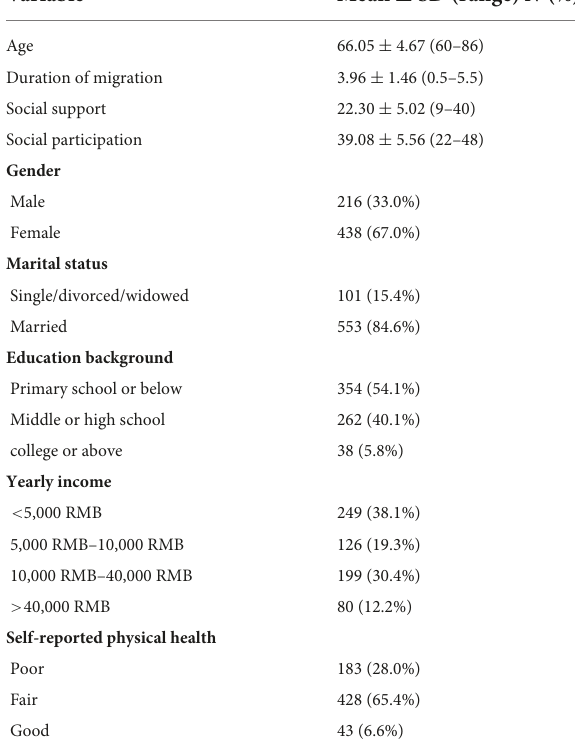
TABLE 1 Sociodemographic information of the participants ( n = 654).